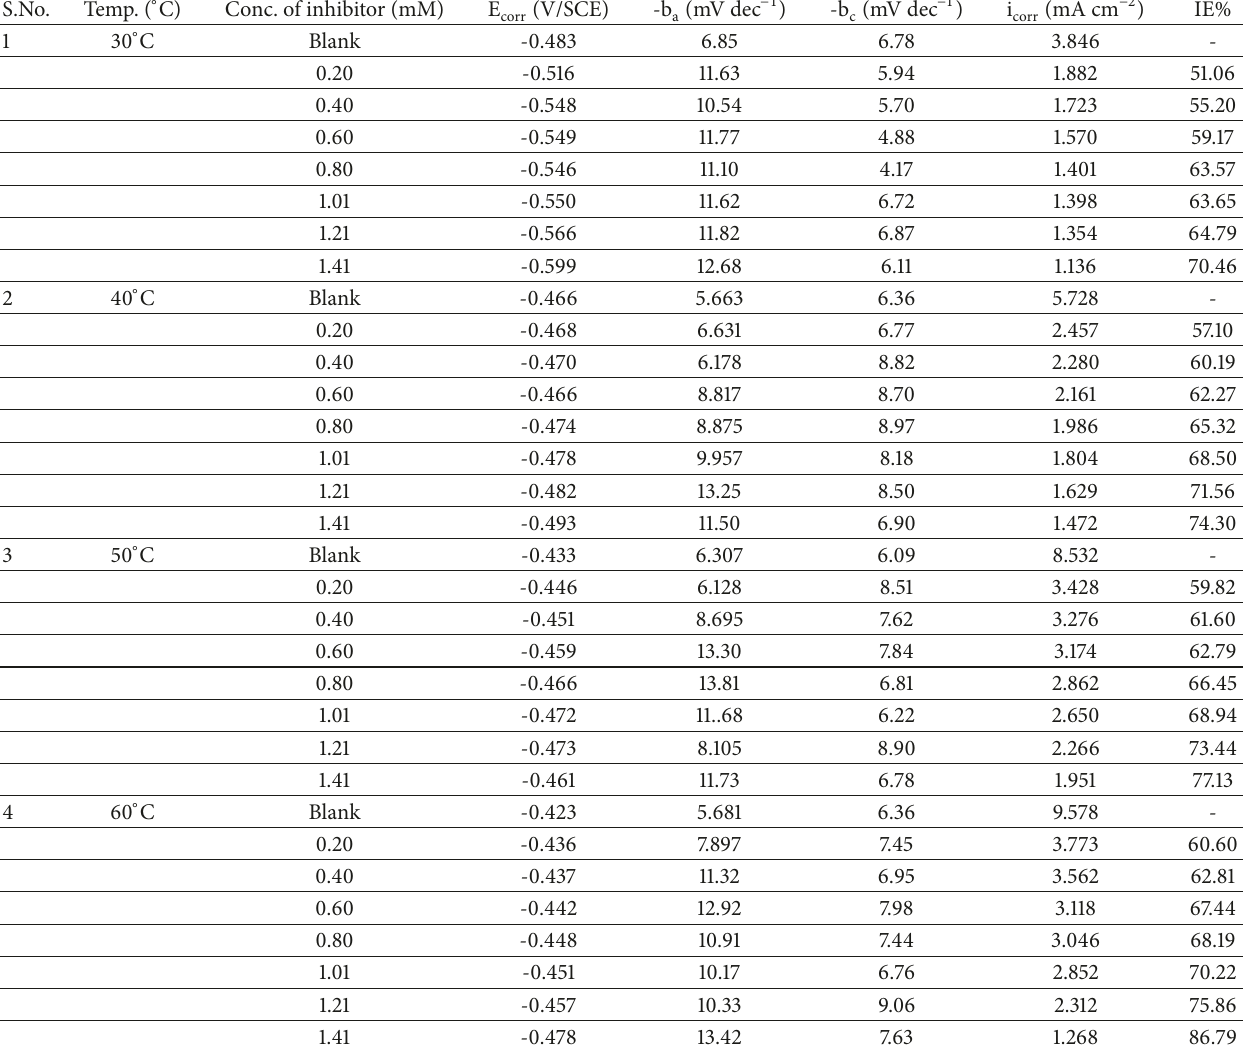
Table 2: Tafel polarization parameters for brass in 1M HCl with BFC from 30 ∘ C to 60 ∘ C.